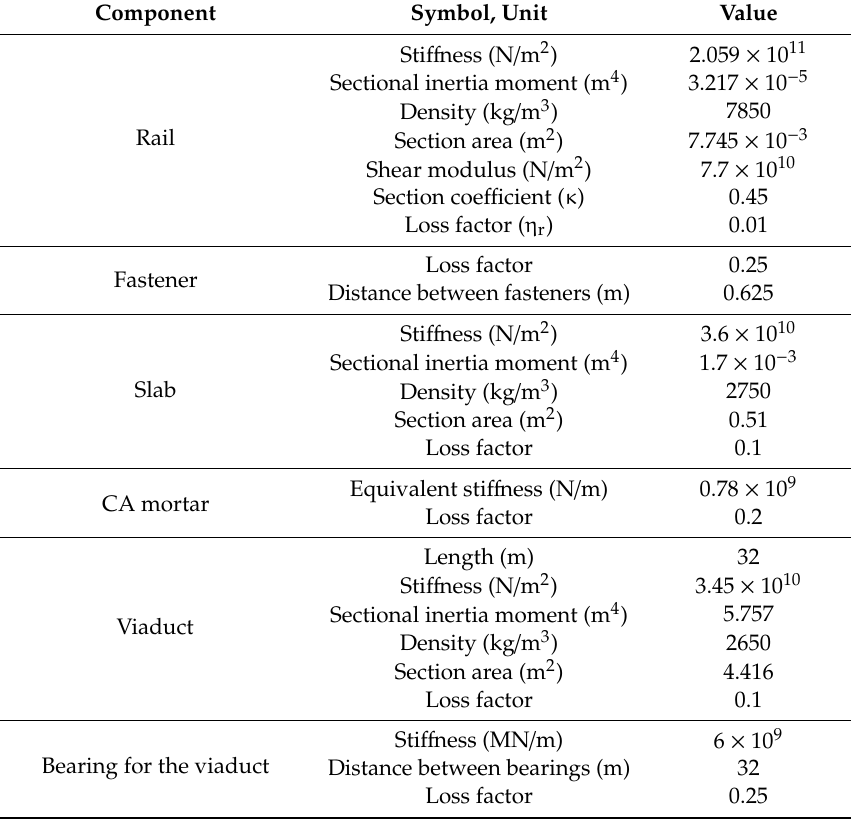
Table 3. Dynamic parameters of the slab-rail-viaduct